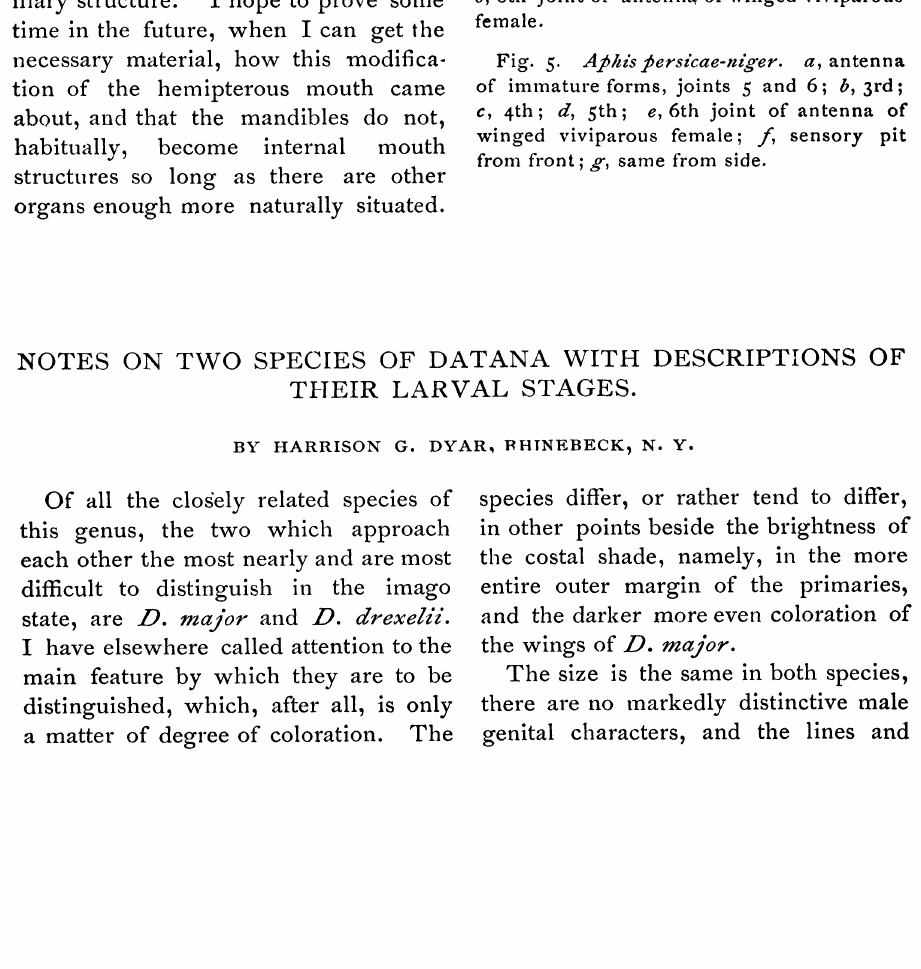
Fig. 4. Myzus cerasi,